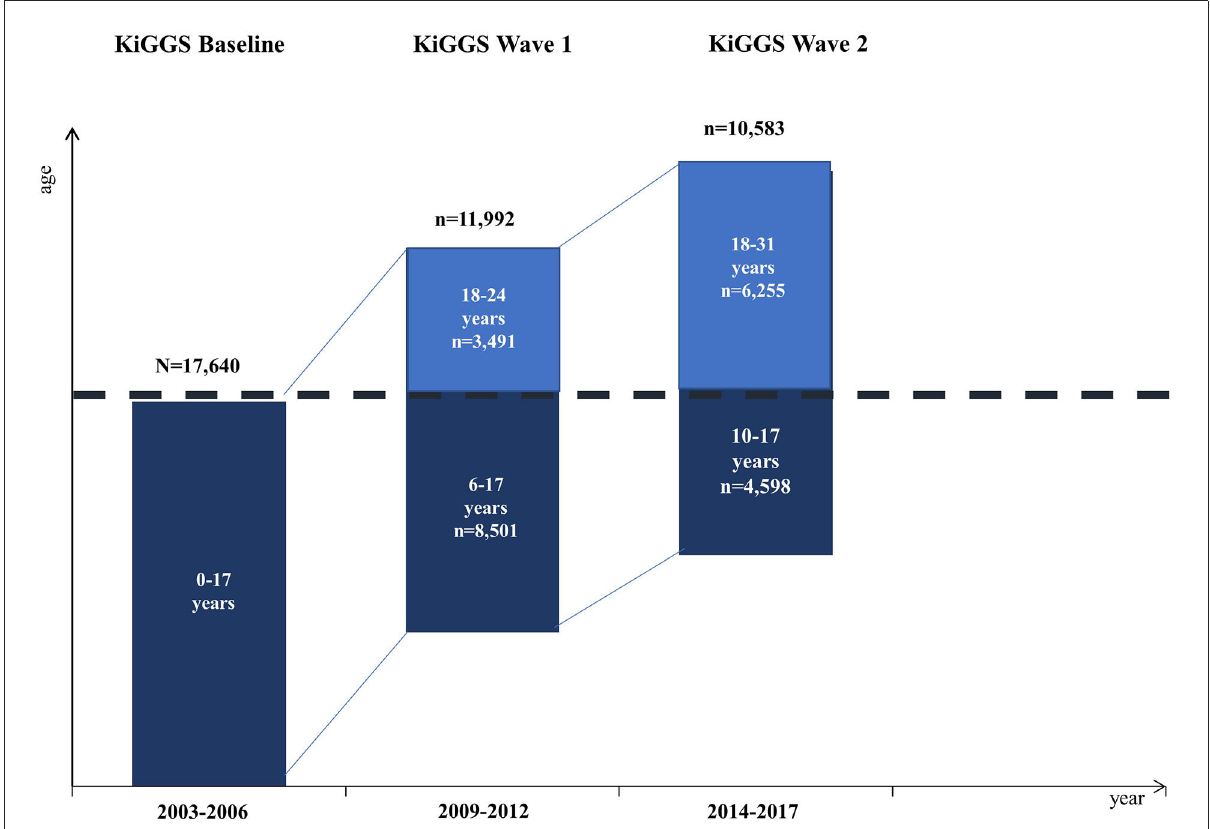
FIGURE1 Longitudinal sample sizes of the KiGGS study. Dark blue bars: Longitudinal data from study participants not older than 17 years (the data used for analyses in this study). Light blue bars: Longitudinal data at Wave 1 and Wave 2 older than 17